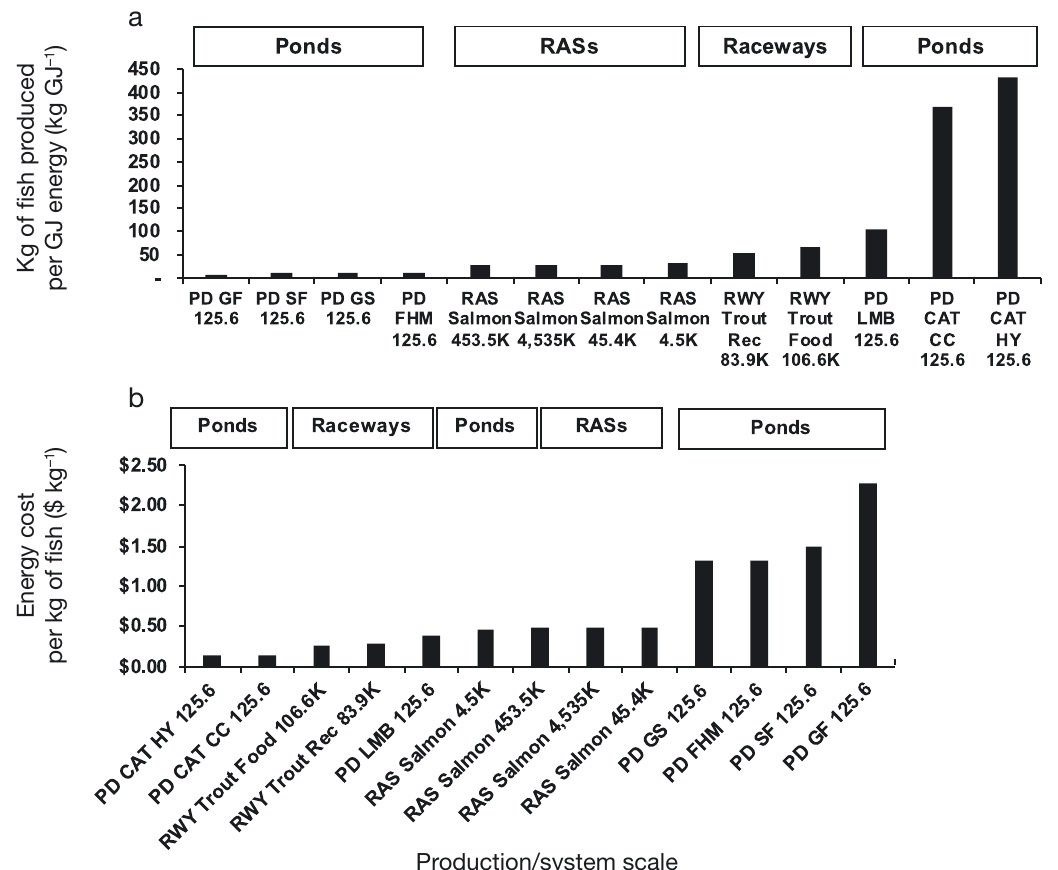
Fig. 4. (a) Energy productivity and (b) energy cost across production systems. In scenarios where production scale did not affect relative rankings, only one production scale was presented. Abbreviations as in Fig.